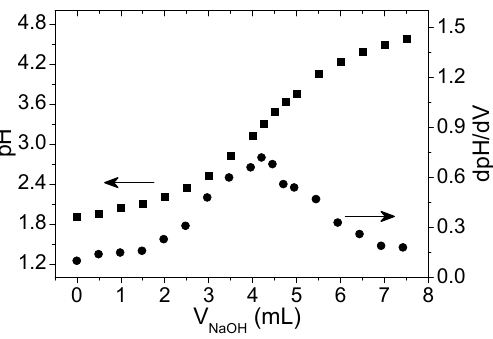
Figure 1. Hydroxylamine hydrochloride titration method for oxidized xanthan gum (XGox) sample with a measured aldehyde content of 61%.